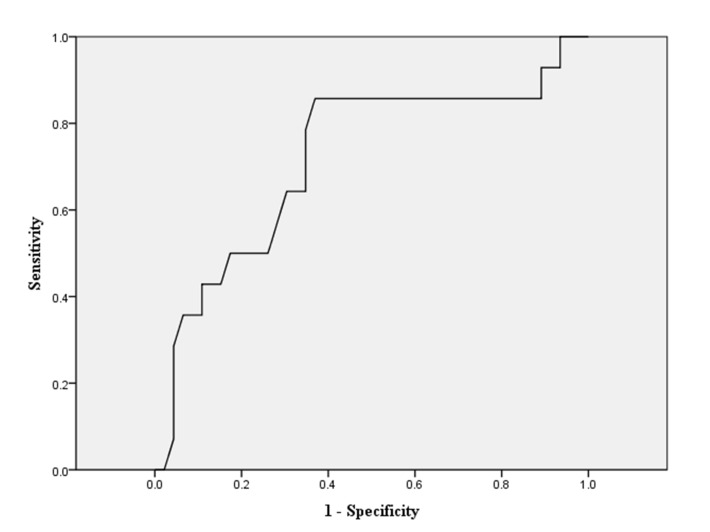
The ROC curve for the OSTA index predicting good neurologic recovery in the older group (age≧40).ROC curve of OSTA index with respect to detecting GOS 1–4 with an AUC of 0.719.